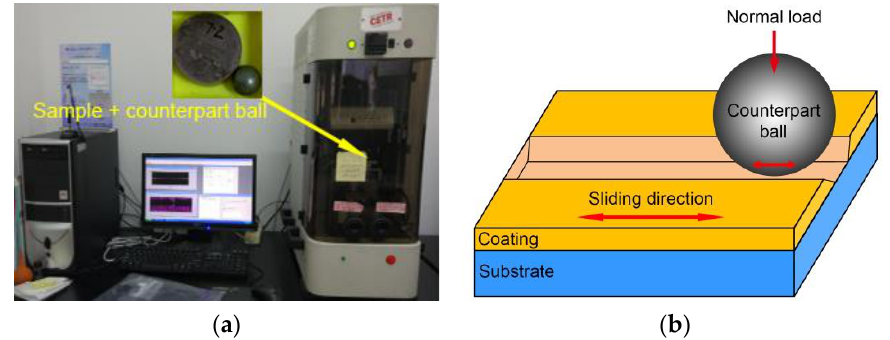
Figure 1. Tribological tests device and its working mode: ( a ) UMT-3 equipment and the sample; ( b ) schematic illustration of the ball-on-flat friction.